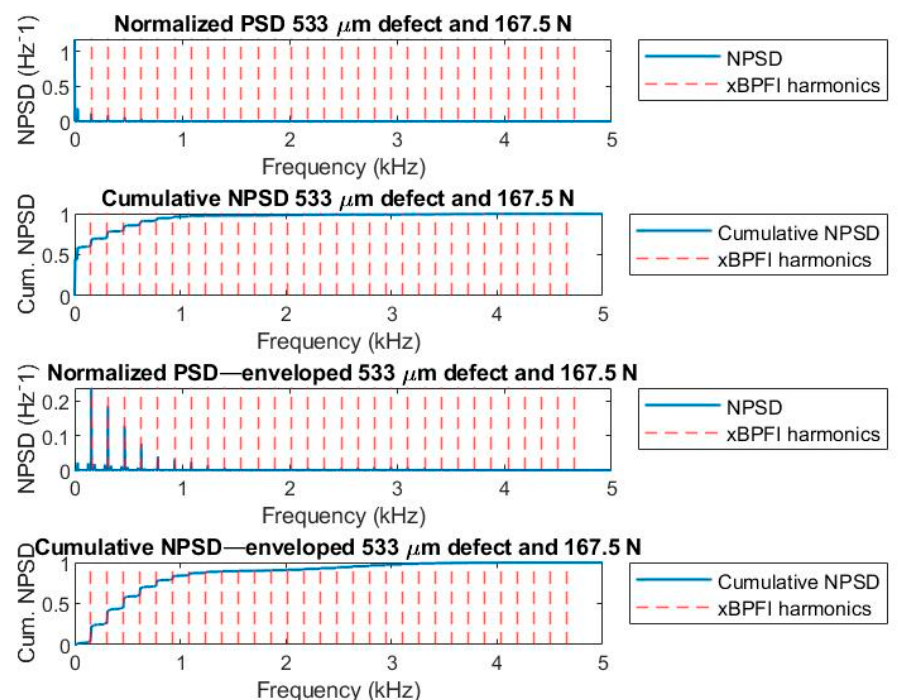
Figure 16. Normalized power spectral density (NPSD) and cumulative NPSD nonenveloped and enveloped signals: pressure signal.